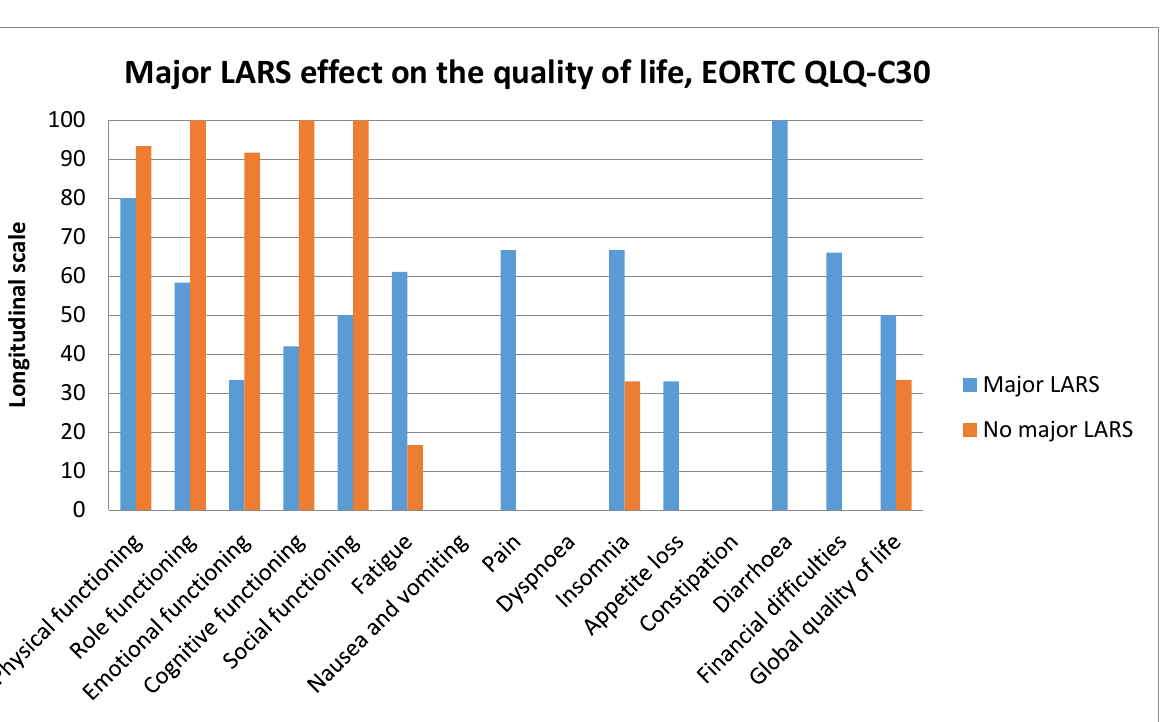
Figure 3. Major low anterior resection syndrome (LARS) effect on quality of life *. * Two groups: 26 patients in the early closure group and 25 in the standard closure group compared. For quality of life assessment, EORTC QLQ-C30 was used. For bowel function (low anterior resection syndrome—LARS), assessment validated low anterior resection syndrome score was used. It consists of five questions related to bowel function following the low anterior resection: incontinence for flatus and/or liquid stool, frequency of bowel movements, clustering of the stools, and fecal urgency. The score of <21 points means no LARS, score from 21 to 29 points—minor LARS, whereas 30 to 42 points indicate major LARS. Independent samples Mann–Whitney U test was used.